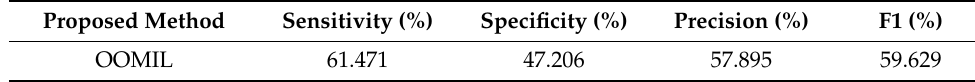
Table 5. Different performance measurements of our model.